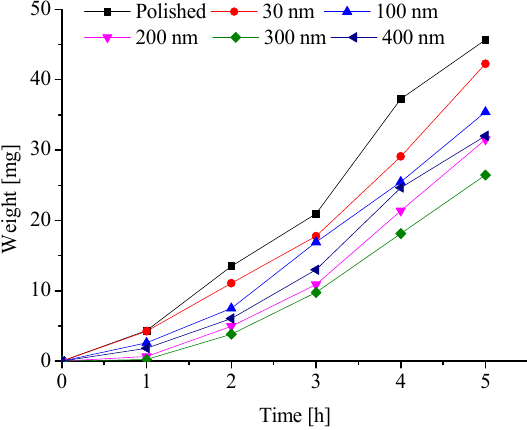
Figure 12. Variations of frost weight with different nanoporous diameters at T = − 15 °C, φ = 60%.